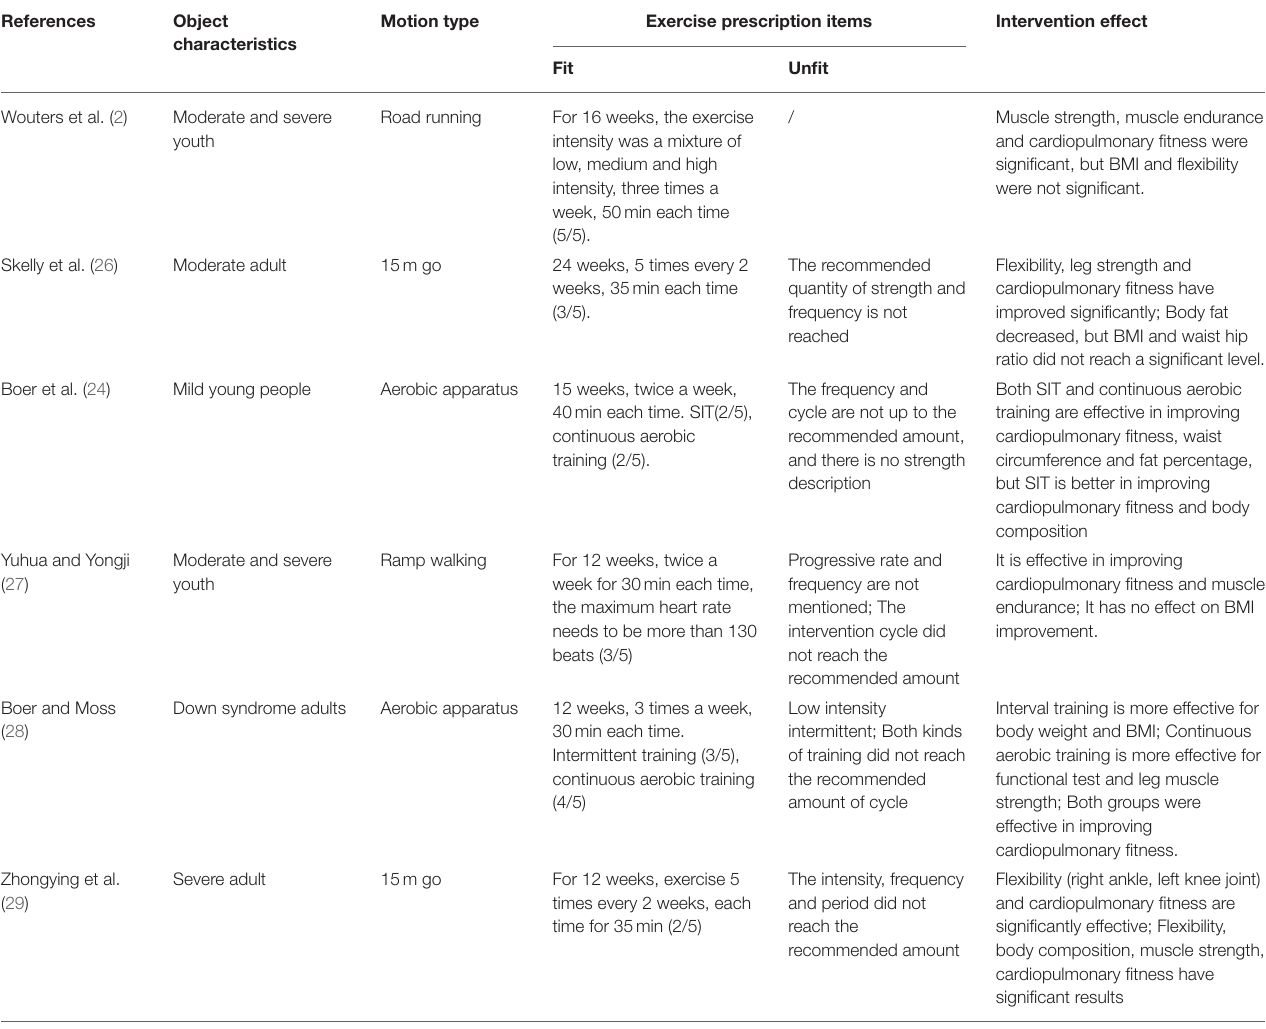
TABLE 2 | Effects of an exercise intervention on physical fitness and body composition of persons with intellectual